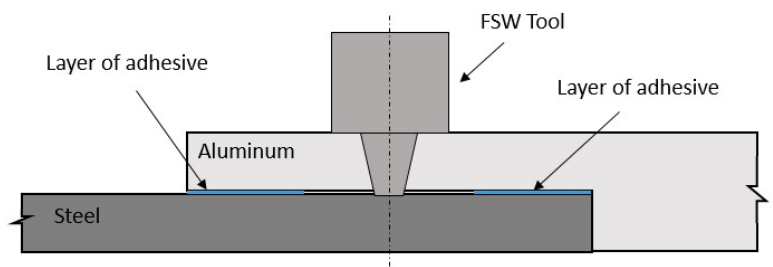
Figure 5. Schematic illustration of the hybrid joining technology FSW ‐ AB [40].